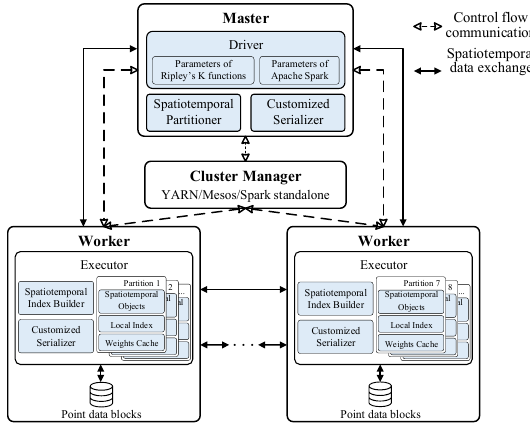
Figure 1. Master-slave mode of distributed K functions